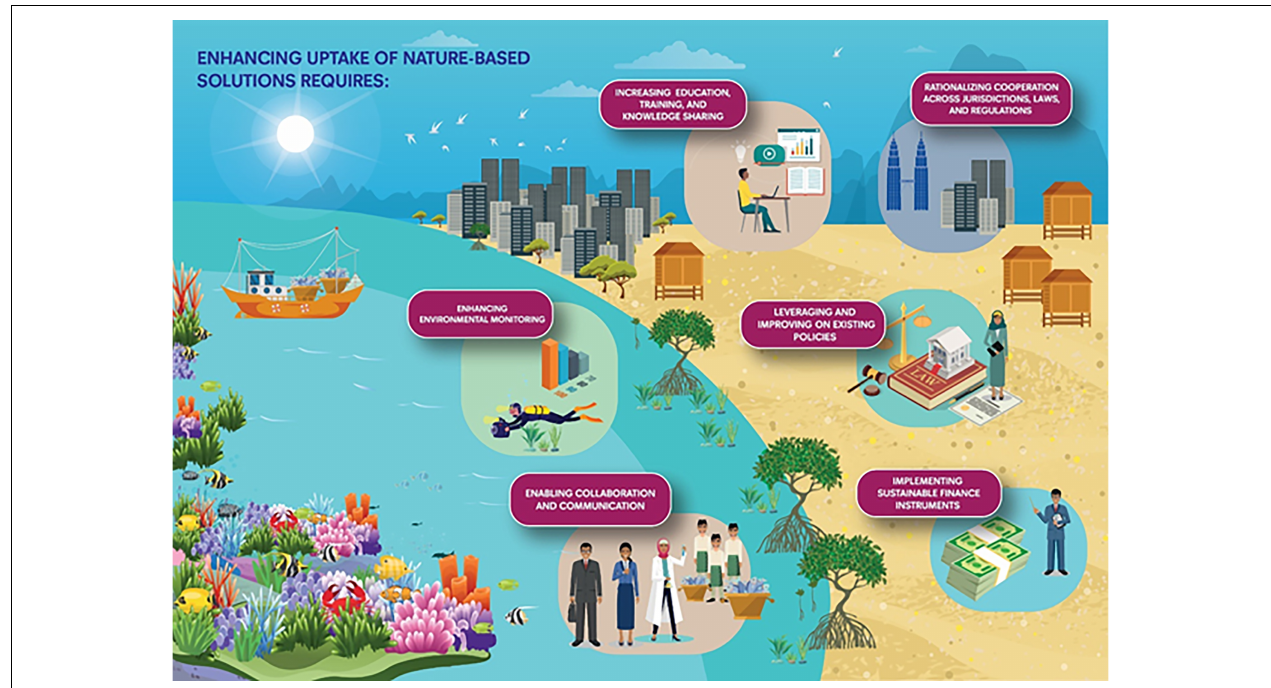
FIGURE 4 | To increase application and uptake of NbS in Malaysia and elsewhere, scientific and local knowledge should be shared though education and training programs to increase the probability of success of NbS efforts; jurisdictions, legislations, and regulations should be rationalized or standardized to eliminate contradictions and close gaps; long-term, sustained observations should be used to monitor the success of NbS efforts; existing policies should be strengthened and made more inclusive of NbS; communication and collaborative efforts among all stakeholders should be strengthened to best use resources and facilitate ecosystem stewardship; and funding for NbS schemes should be sufficient and